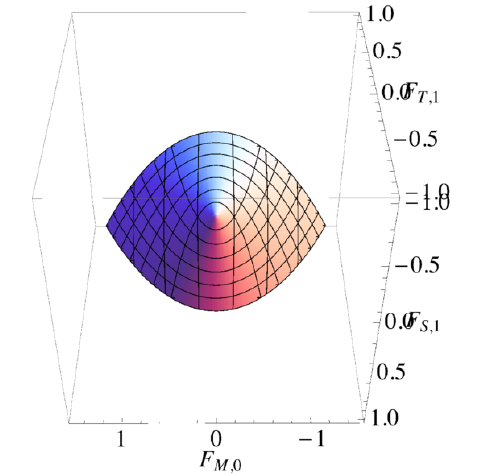
Figure 15 . Same as (cid:12)gure 14, but in the subspace spanned by F S; 1 , F M; 0 and F T; 1